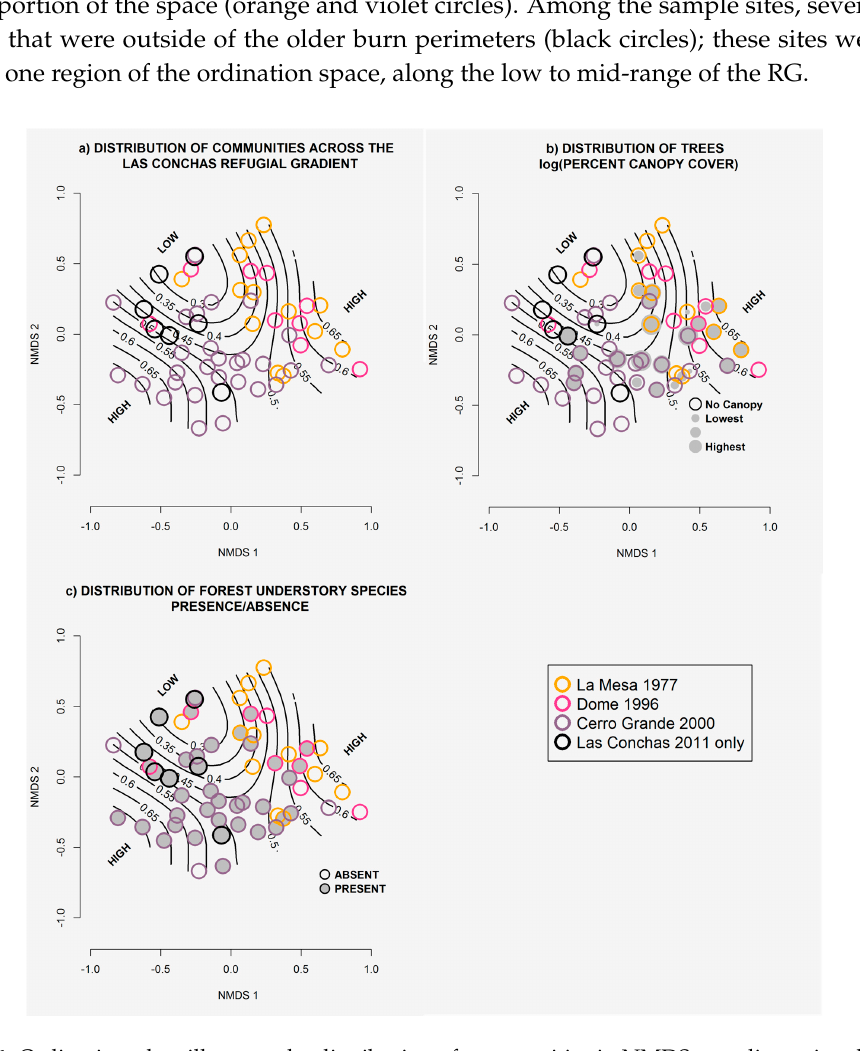
Figure 4 Figure 4. Ordination plots illustrate the distribution of communities in NMDS two-dimensional space (i.e., circles). The environment was modeled using the Las Conchas RG (black contours, direction of gradient is labeled as HIGH-LOW-HIGH). All sites (i.e., field plots) burned in Las Conchas; those that burned in one of the three previous fires are indicated by colored circles ( a – c ); those that burned in Las Conchas only are shown as black circles. Communities within the different burns generally overlapped in ordination space ( a ); trees varied in abundance based on canopy cover ( b ); one or more species characteristic of the forest understory were present across the gradient, including at some sites with no trees ( c